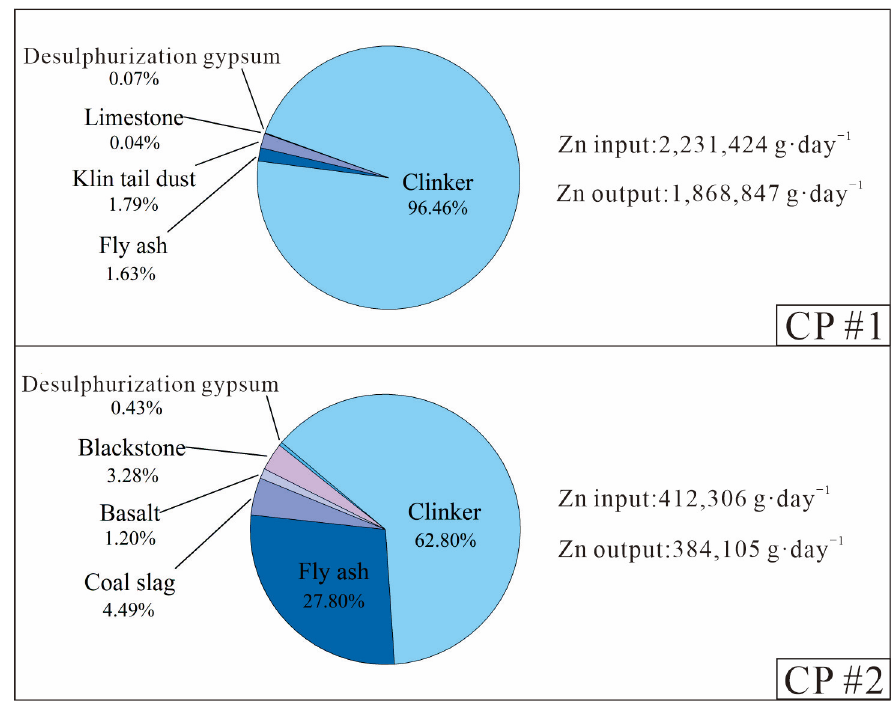
Figure 3. Breakdown of the daily Zn inputs and outputs during the clinker-to-cement production process of two CPs.